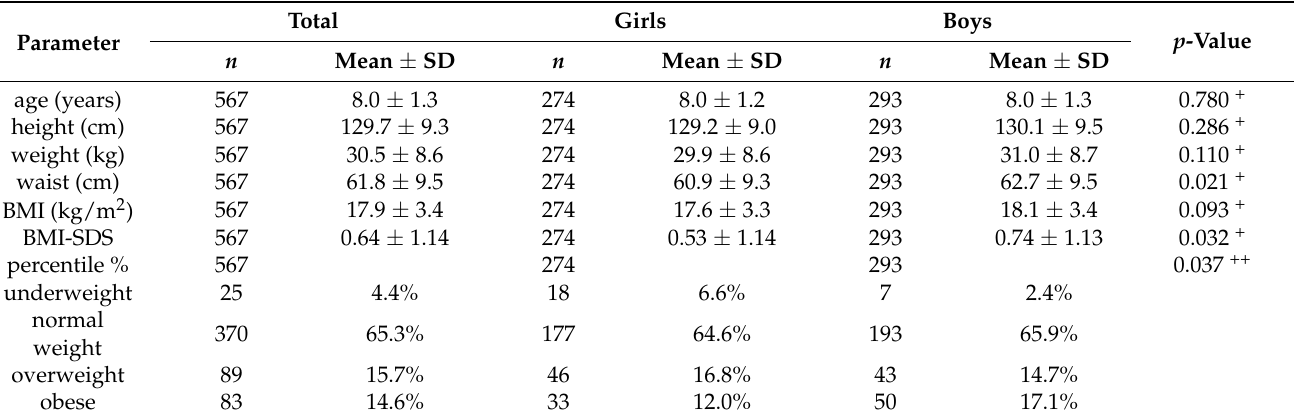
Table 2. Descriptive statistics of anthropometric data broken down by